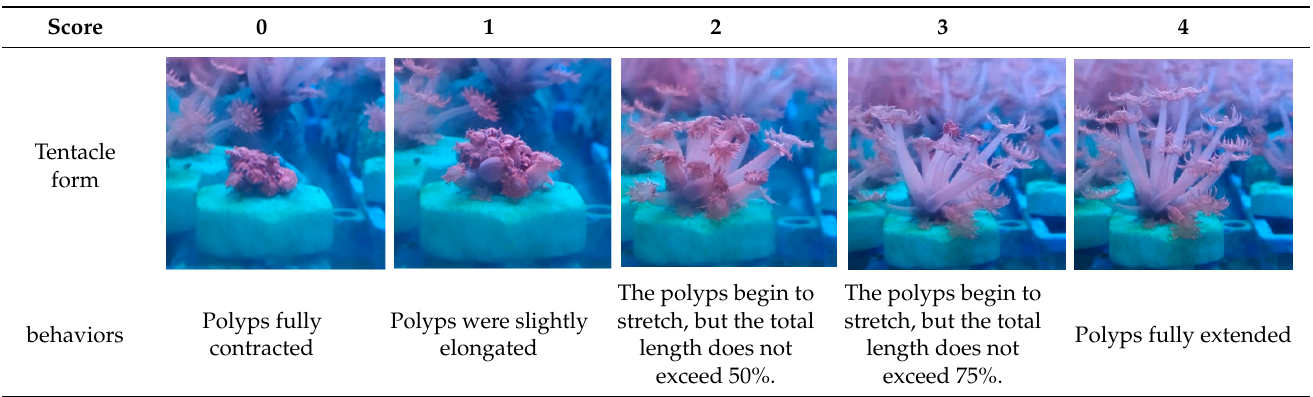
Table 3. Score of polyps stretching and contractile behaviors at salinity 30–35 psu and temperature 25 °C.